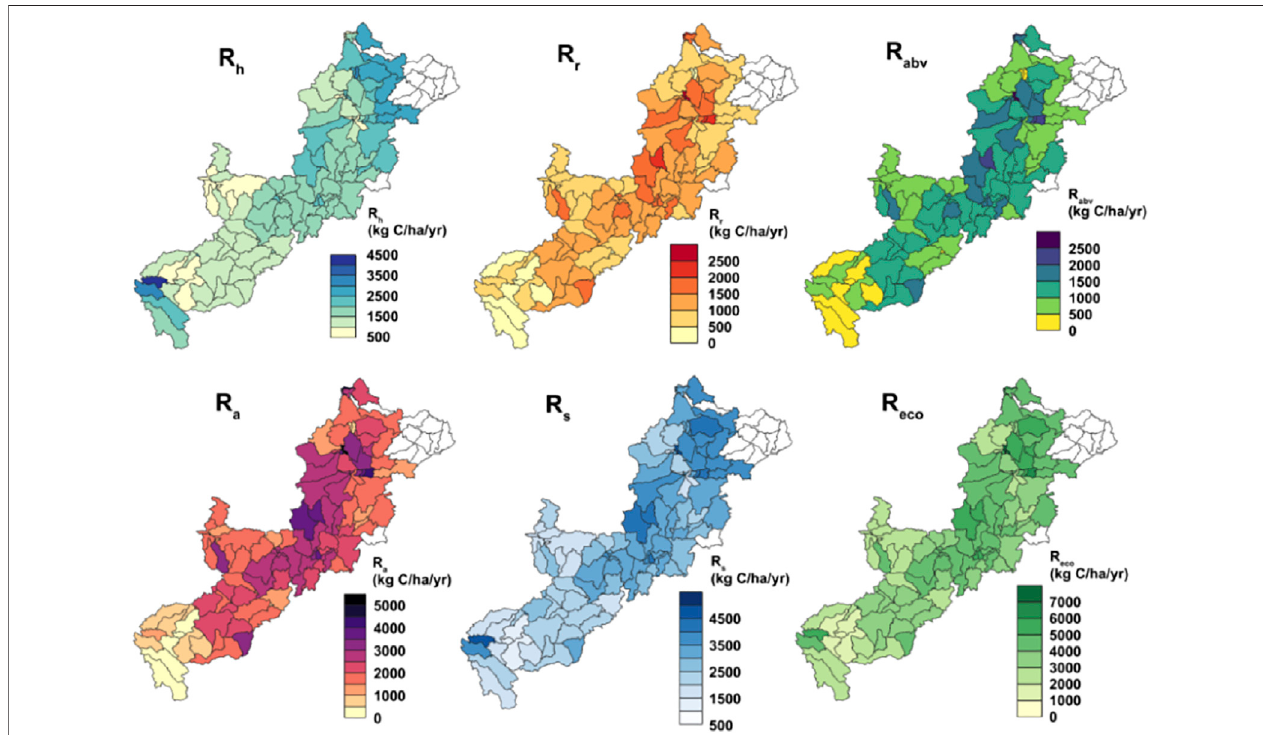
FIGURE1| Subbasin-wise,long-termmodeled(2000 – 2013)annualaveragemapsofsoilheterotrophicrespiration( R h ),rootrespiration( R r ),autotrophicrespiration from above-ground autotrophic respiration ( R abv ), autotrophic respiration ( R a ), soil respiration ( R s ), ecosystem respiration ( R eco ) in kg C ha − 1 yr − 1 . The northernmost regions are not modelled and are shown